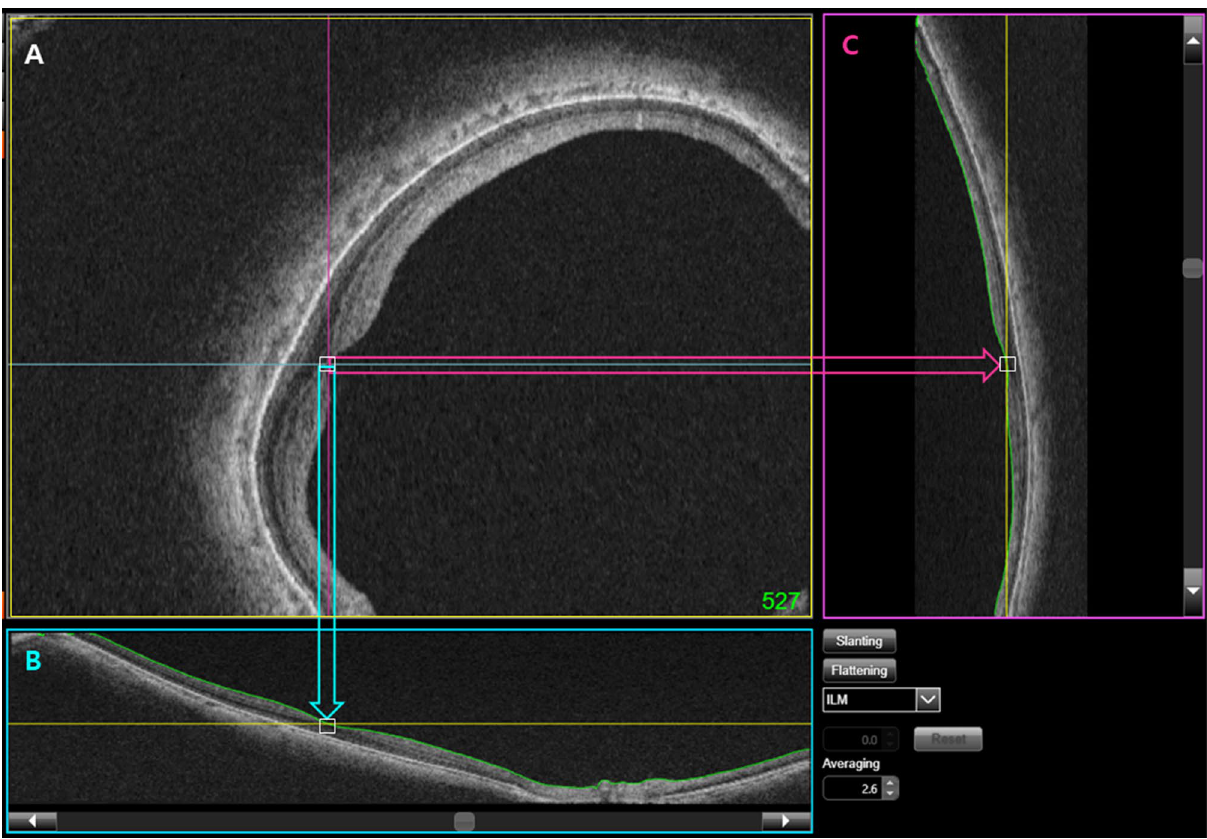
Figure 2. Designation of the fovea using the coronal ( A ), horizontal ( B ), and vertical ( C ) scan. The specific coronal section (given in green numbers in the ( A )) that simultaneously displayed the foveal double hump in all three displays ( A – C ) was designated as the foveal